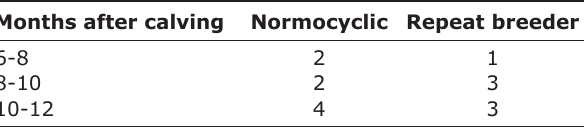
Table-3: Lactation stage of normocyclic and repeat breeder cows.